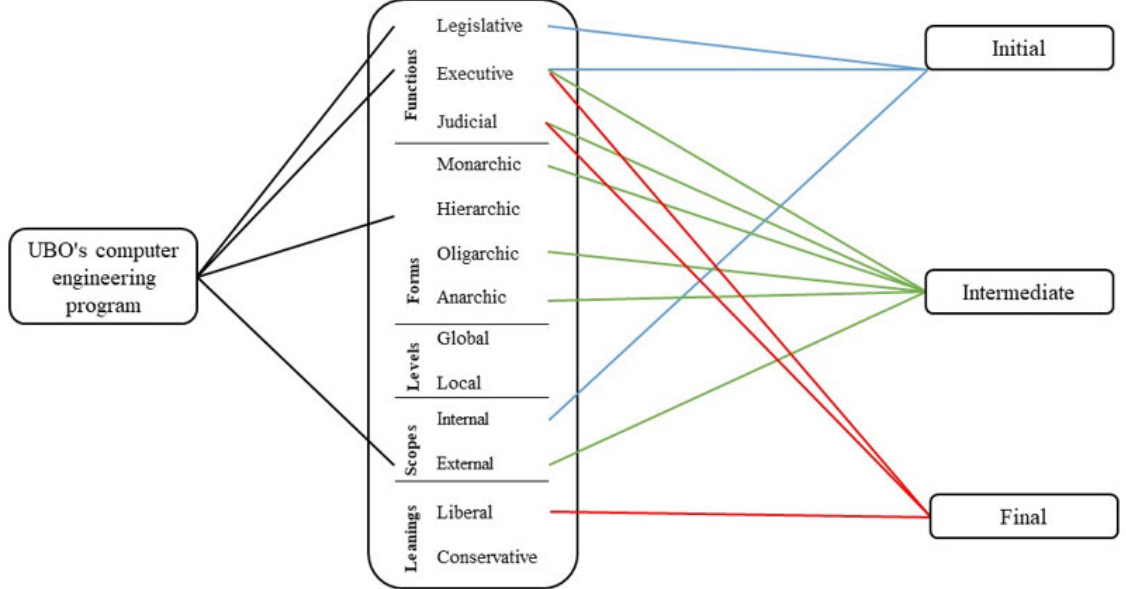
Figure 3. Dynamics of the preferences described by the students, knowing the institu- tional